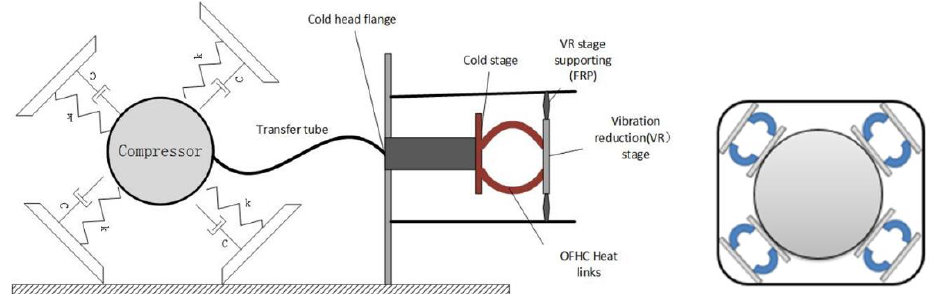
Figure 1. Portable EMC vibration reduction system for HPGe detector.